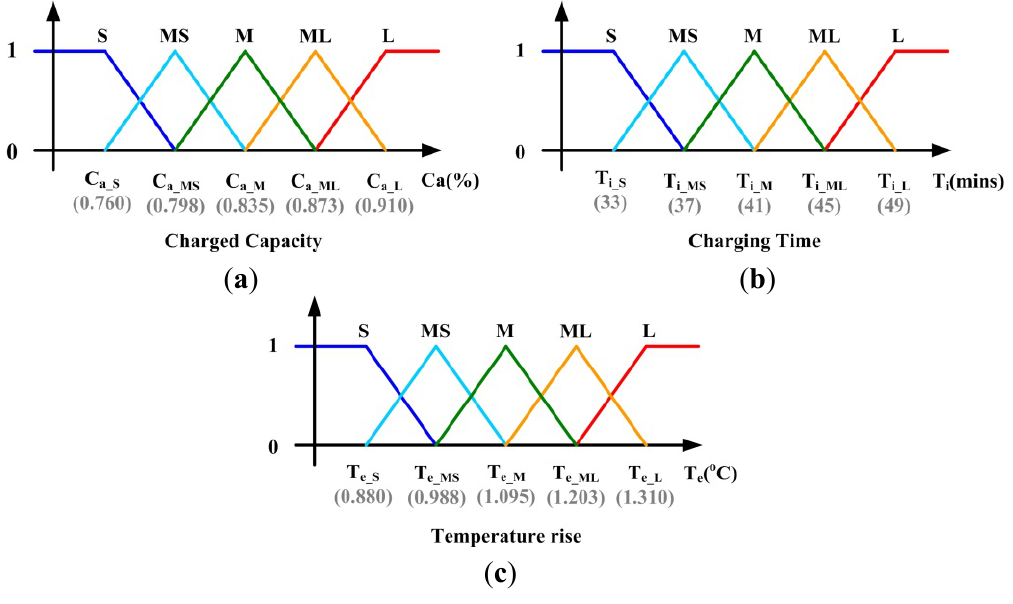
Figure 6. Input MFs of the proposed FLU ( a ) Input membership function for the charged capacity; ( b ) Input membership function for charging time; ( c ) Input membership function for temperature